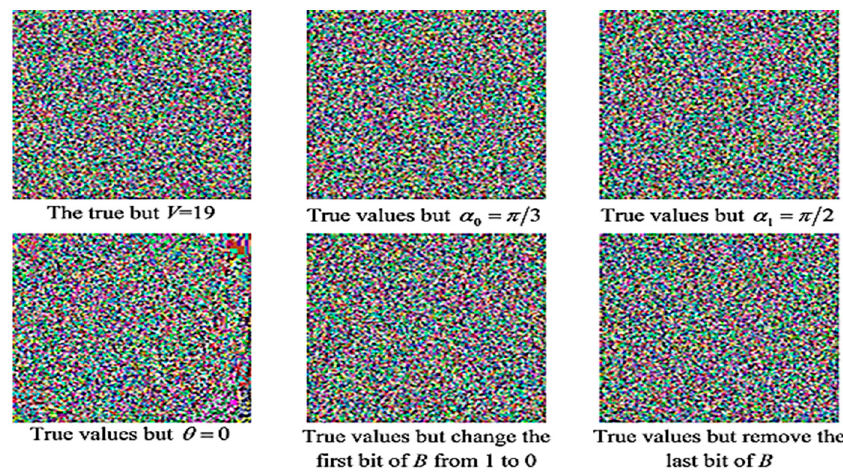
Figure 9. Extracted secret image MDG04 recovered from the stego image MDG01 for varying changes in key parameters.